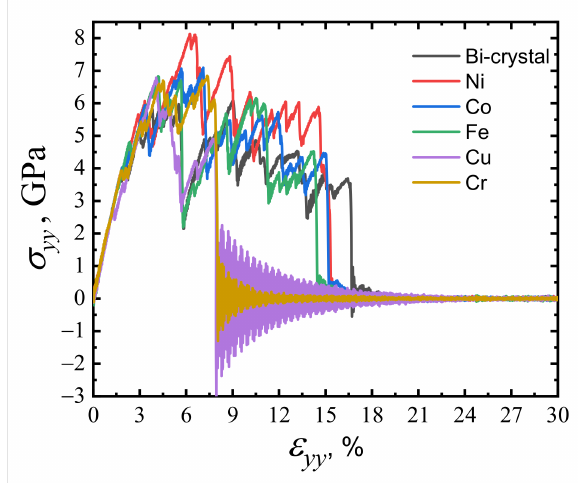
Figure 6. The tensile stress–strain curves for the considered bicrystals. The corresponding type of segregated element is indicated in the legend for each bicrystal, while the case without GB segregation is denoted as Bicrystal. The stress drop to zero corresponds to a break in the bicrystal. The considered temperature is 300 K.